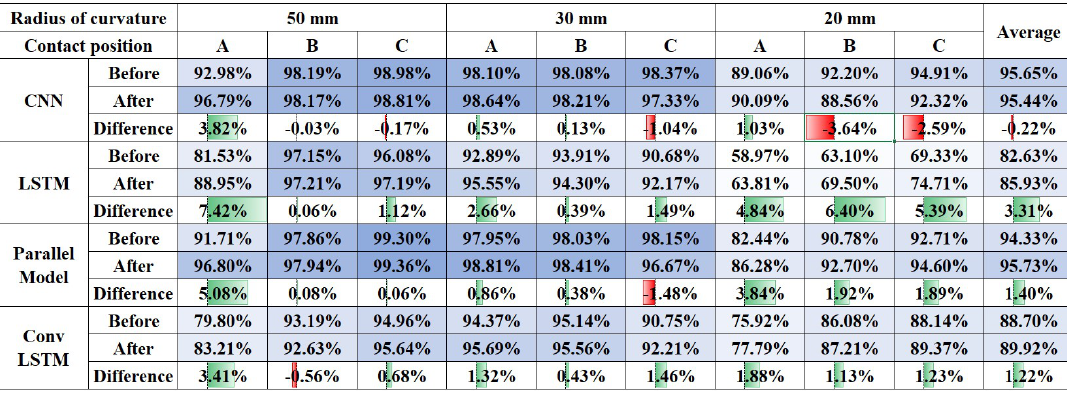
Figure 13. Comparison of accuracy before and after transfer